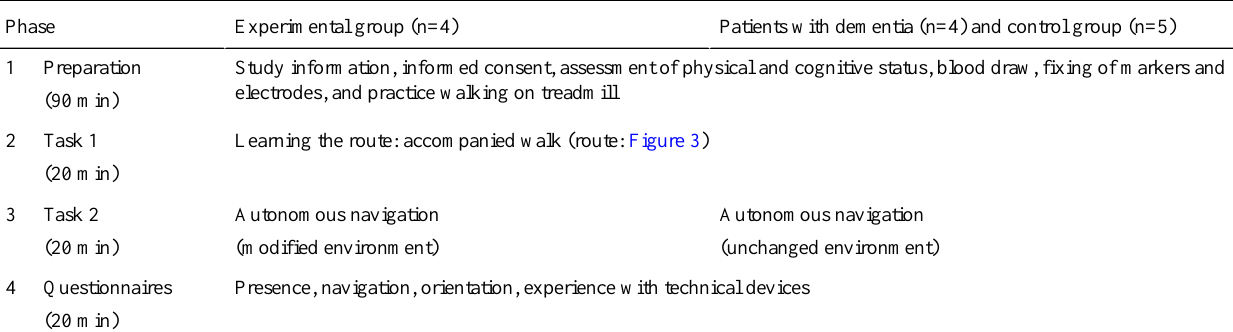
Table 1. Experimental procedure for the cognitively healthy older participants (n=9) and patients with dementia (n=4). The patient group followed the procedure of the control group.